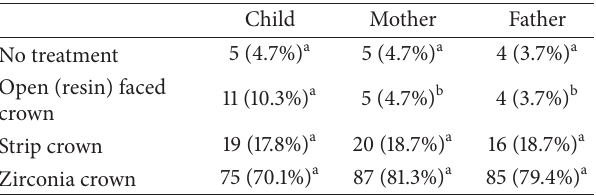
Table 4: Esthetic acceptability of treatment for anterior teeth with deep caries.